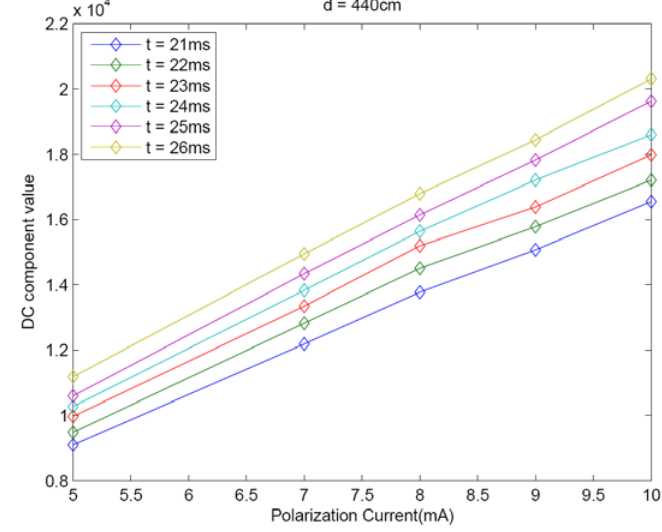
Figure 4. Behavior of the DC component with IRED polarization current for different camera exposure